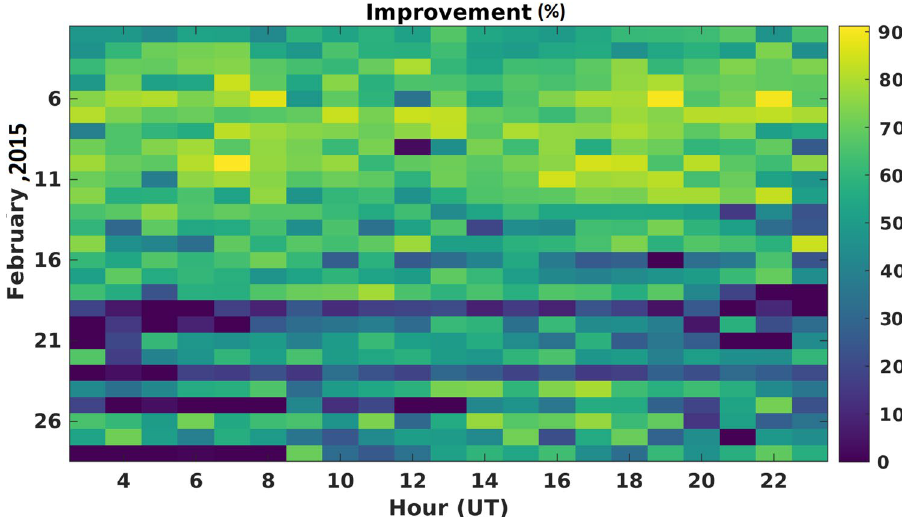
Figure 2. An overview of the improvements (from Eq. (6)) in forecasting TNDs during February 2015. The results are estimated by running the original NRLMSISE-00 and C/DA-NRLMSISE-00. The C/DA is processed using GRACE-TNDs as observations, then the 3-hourly calibrated parameters are used to form the C/DA-NRLMSISE-00 model and forecasting TNDs along Swarm-C during different times of the month. The quality of forecasts is found to be 50.62 % improved, on average. The plot was made in MATLAB (version R2021a, https:// www. mathw orks.